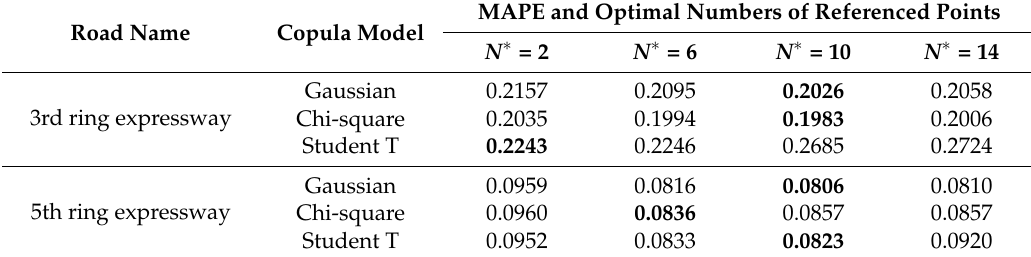
Table 6. Performance of copula models based on MAPE at12:00 (timestamp = 360) on 1 June 2015.